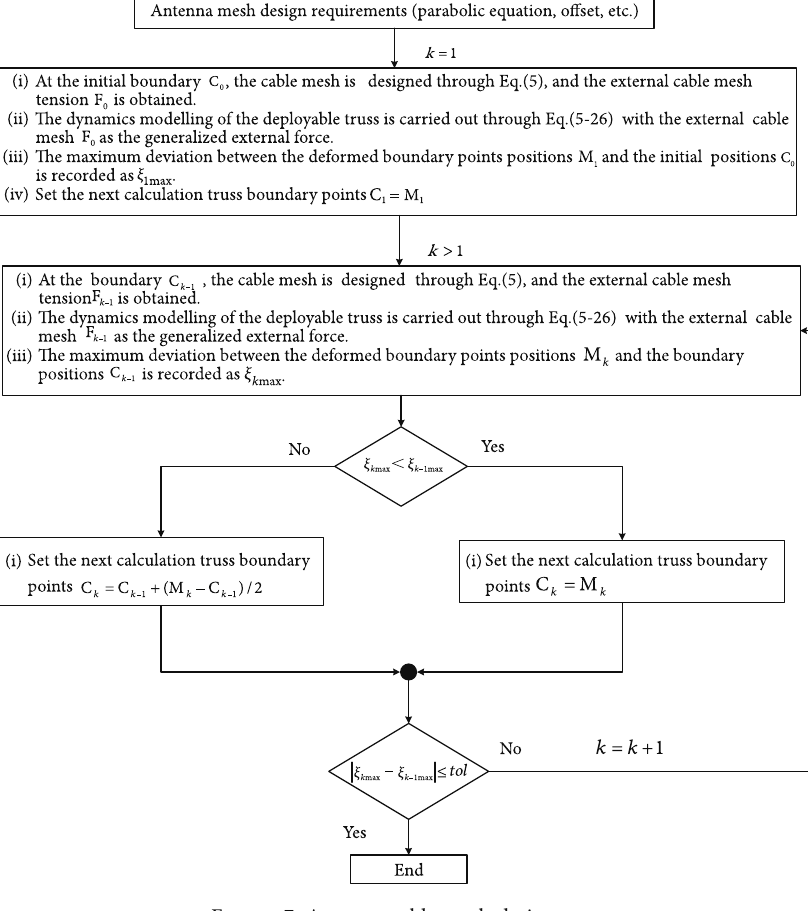
Figure 7: Antenna cable mesh design process. Table 3: The parameters of simulation